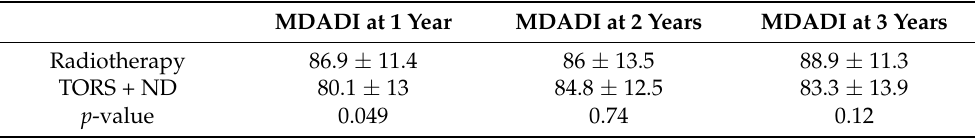
Table 2. ORATOR clinical trial: Long term swallowing